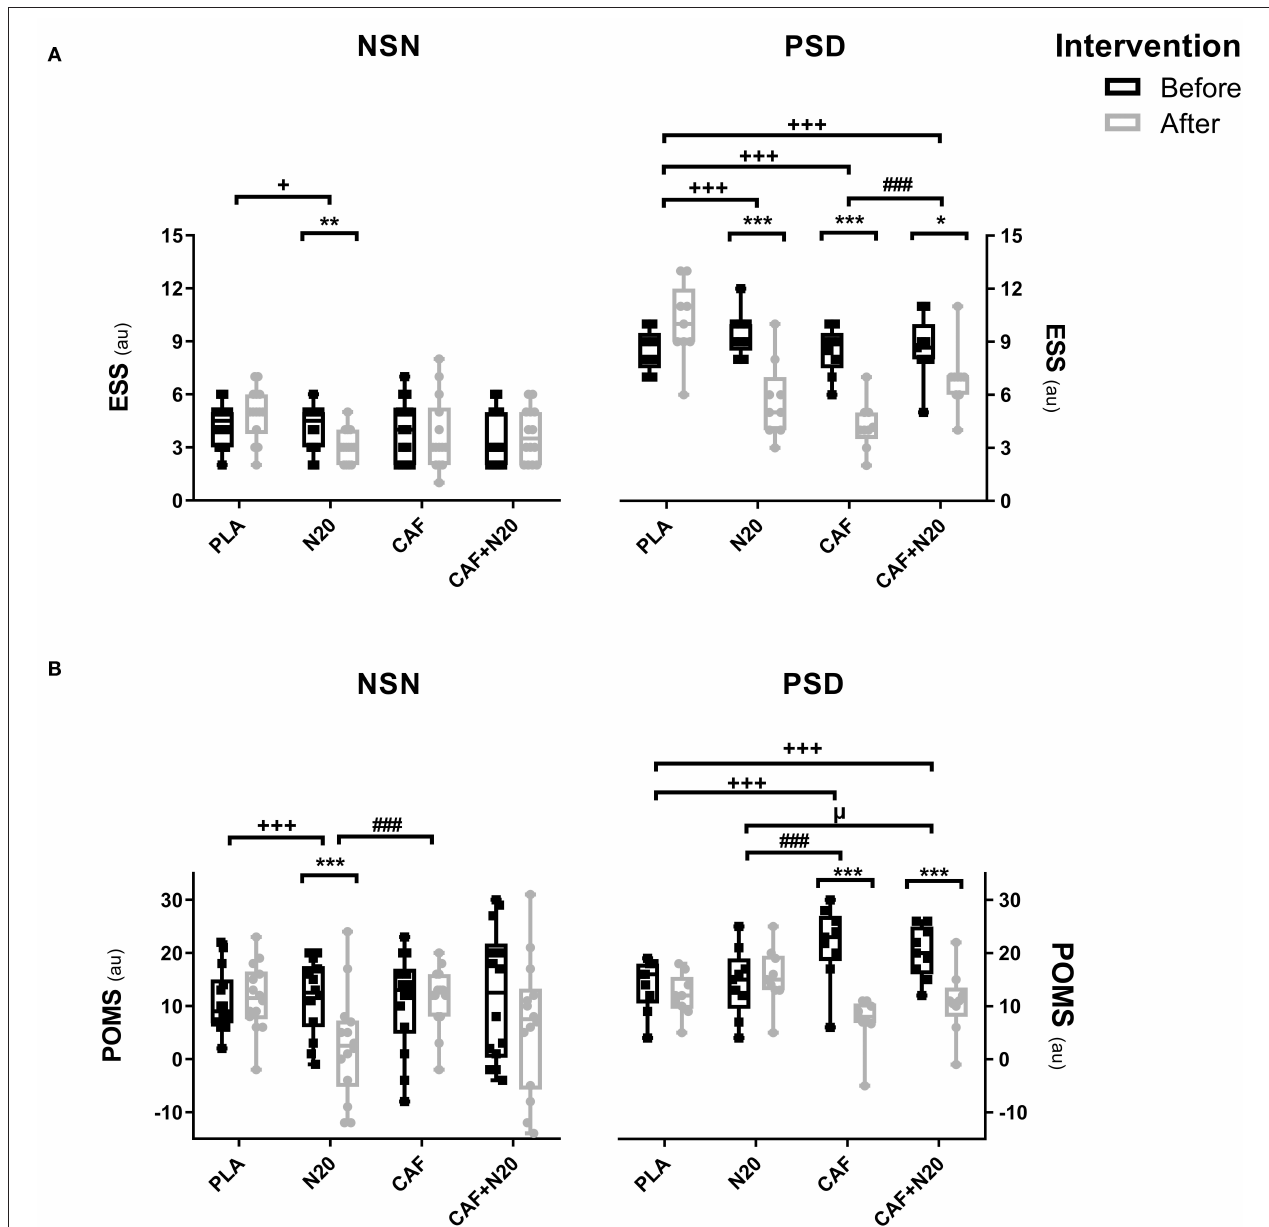
FIGURE 3 | Mean ± standard deviation of Epworth sleepiness scale (ESS; A ) and profile of mood state (POMS; B ) during different protocol sessions; PLA, placebo ingestion, N20, 20min nap with placebo ingestion, CAF, 5mg · kg − 1 of caffeine, CAF + N20, 5mg · kg − 1 of caffeine + 20min nap after a night of normal sleep (NSN; left panel) partial sleep deprivation (PSD; right panel). Significance was determined using a Two-way repeated measure ANOVA. Significance for pairwise comparison is determined with Bonferroni post-hoc test. *, ** and *** presents a significant difference in comparison with pre-intervention values at p < 0.05, p < 0.01 and p < 0.001 respectively, + , ++ and +++ presents a significant difference in comparison with PLA values at p < 0.05, p < 0.01 and p < 0.001 respectively, # , ## and ### presents a significant difference in comparison with CAF values at p < 0.05, p < 0.01 and p < 0.001 respectively, µ , µµ and µµµ presents a significant difference in comparison with N20 values at p < 0.05, p < 0.01 and p < 0.001